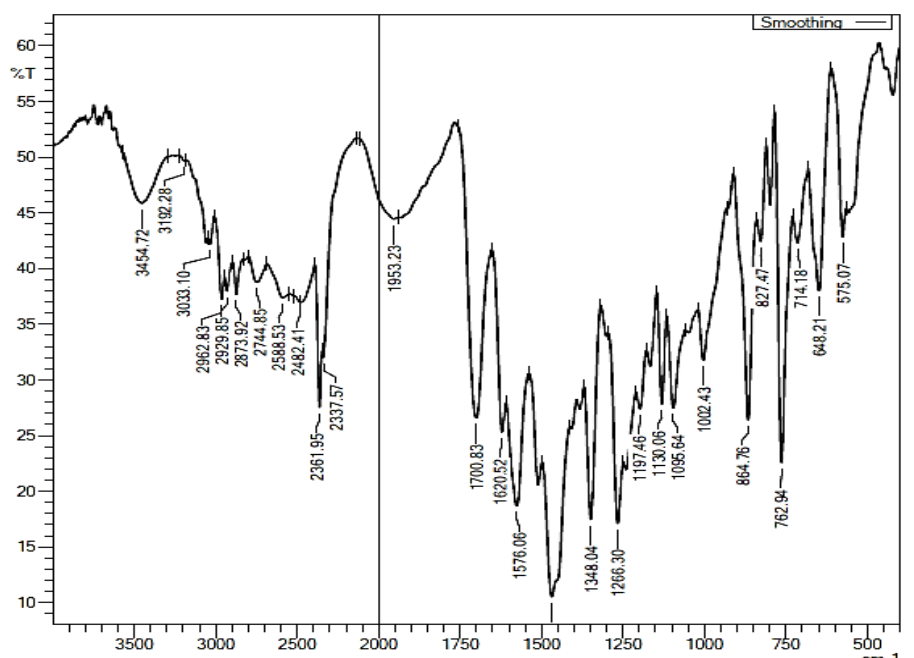
Figure 14. FT-IR Spectra of Telmisartan-Maleic acid Cocrystal (1:1).